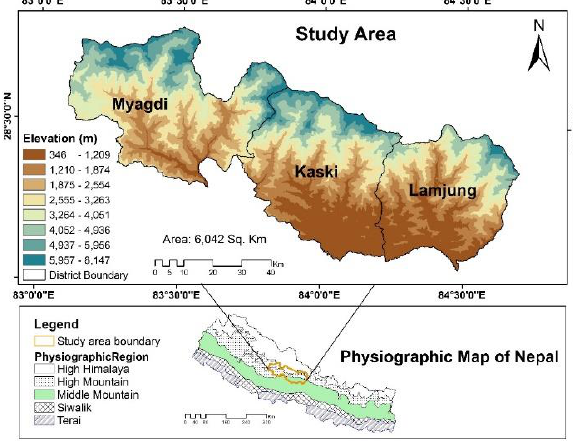
Figure 1. Location of Study Area. (ASTER GDEM 2011 and DFRS